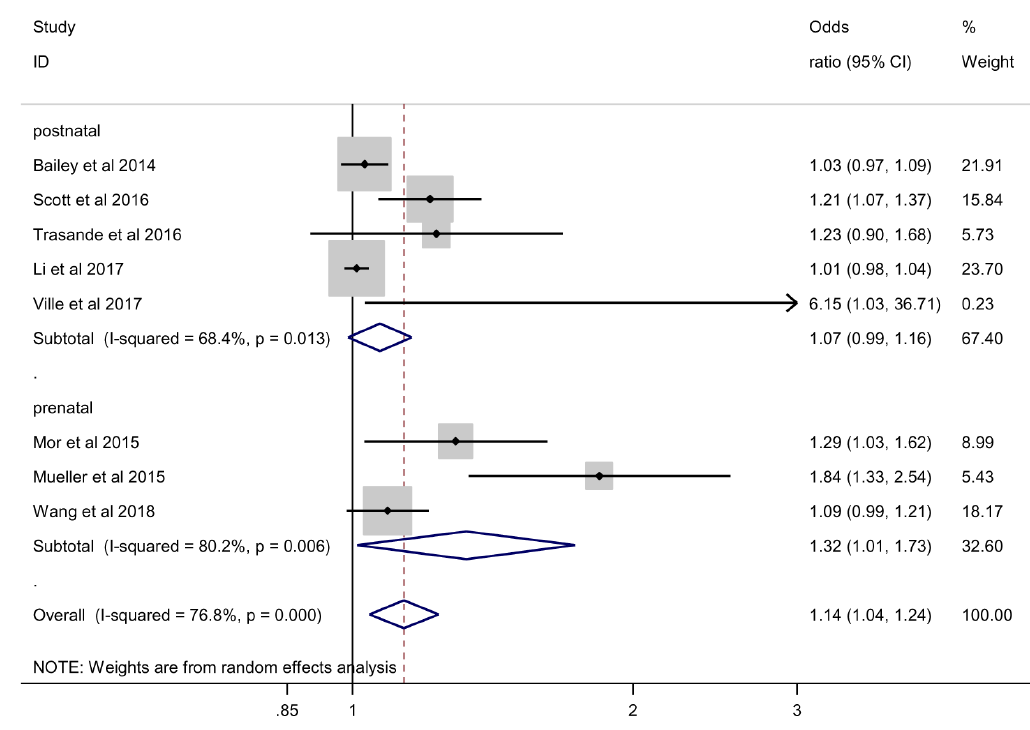
Figure 8. Obesity outcome, subgroup analysis by timing of